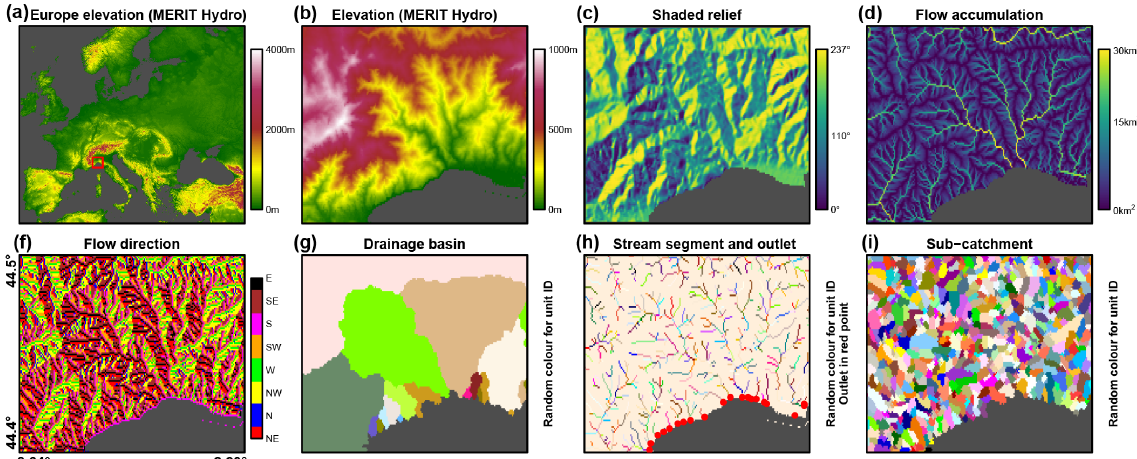
Figure 6. Map (a) shows the MERIT Hydro DEM for an area of 13 × 11km in north-west Italy, and (b–i) show the base and network layers of Hydrography90m. The sea is depicted in dark grey. The outlets are shown in panel (h) as red points.